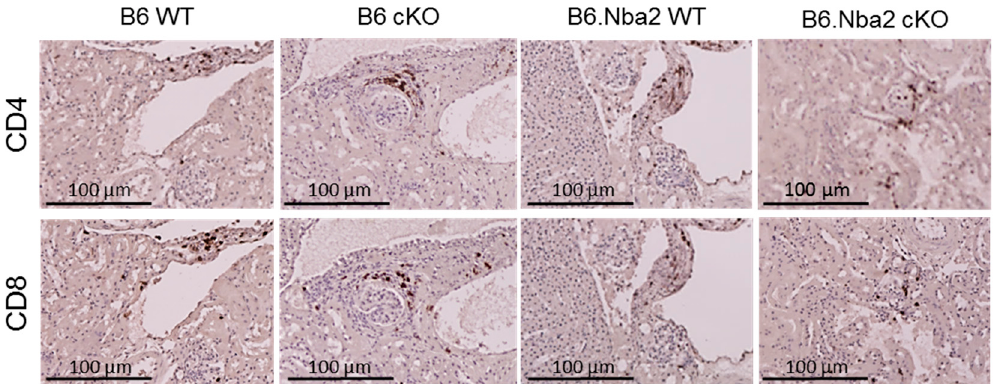
Figure 6. CD4+ and CD8+ T cells infiltrate kidneys independent of T-cell specific IFNAR expression. Kidneys were stained for CD4 (top row) and CD8 (bottom row) and counterstained with hematoxylin (light bluish-brown). CD4 and CD8 staining appears in dark brown. Representative images are shown. B6: n = 2, B6 cKO: n = 2 B6.Nba2: n = 4, B6.Nba2 cKO: n = 5.